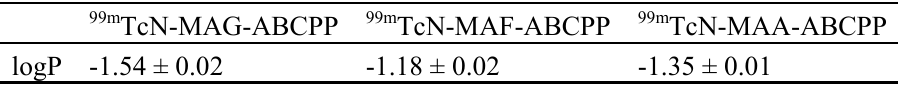
Table 1. Partition coefficients of 99m TcN-MAG-ABCPP, 99m TcN-MAF-ABCPP